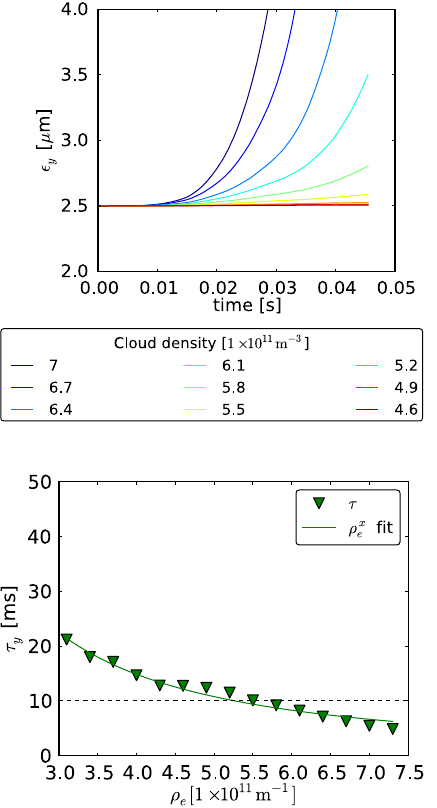
FIG. 17. Top: Emittance evolution for different central cloud densities at an energy of 450 GeV, considering a proton beam passing through a bending field. The legend entries indicate the central cloud densities in 1 (cid:2) 10 11 m (cid:1) 3 . Bottom: The corre- sponding rise time values with threshold set at 10 ms. (cid:5) (cid:5) (cid:6) (cid:1) 2 : 49 e . At low central densities the rise times are in the order of several seconds indicating that a coherent emittance growth is likely to be damped by other mechanisms.